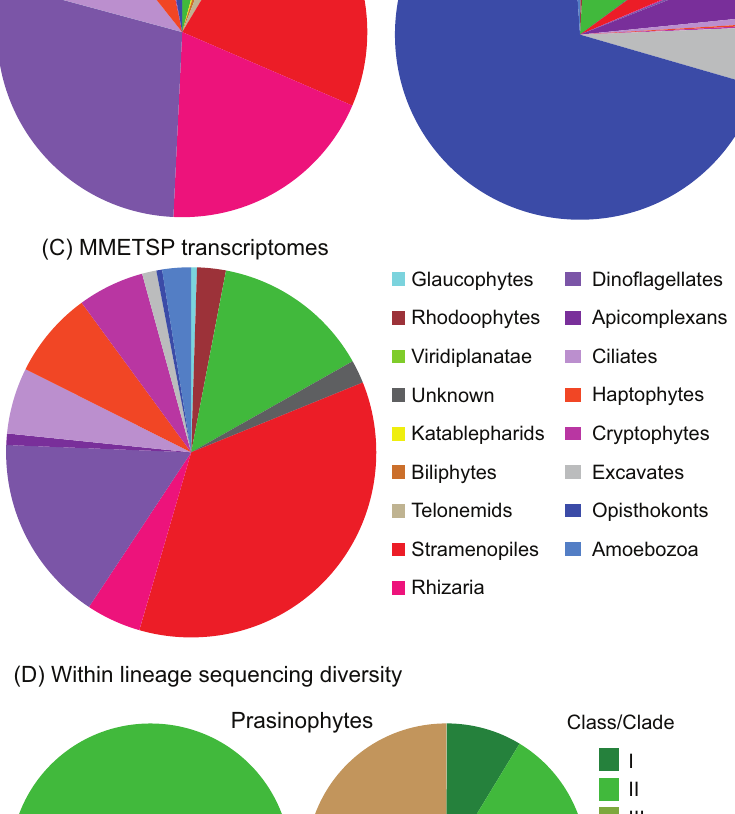
Figure 1. Comparing the diversity of microbial eukaryotes at one marine site with that represented in genome data and the MMETSP project. (A) Taxon assignments for 930 Small Subunit (SSU) rRNA gene sequences from environmental clone libraries built using DNA from three size fractions in sunlit surface waters of the North Pacific Ocean. Four hundred and five se- quences corresponding to Syndiniales (non- photosynthetic members of the dinoflagellate lineage, often referred to as MALV1 and MALV2) were excluded for visualization pur- poses. Syndiniales are not represented in